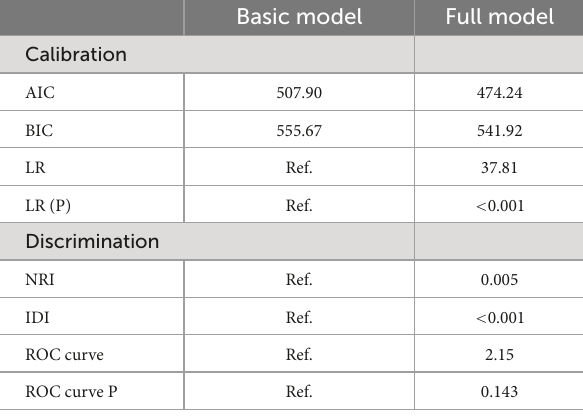
related to have a young age, and in patients with bipolar disorder, the incidence of NSSI was significantly lower in patients between 31 and 60 years old group than 18?–30 years patients. Finally, duration of illness for more than 10 years were more likely to have NSSI than those less than 3 years. (25). Our results also supported that patients with NSSI are younger and had shorter duration of illness, but age and duration of illness did not show statistical significance in the LASSO regression, likely because LASSO regression eliminated the multicollinearity and removed the interaction between age, duration of illness and age of onset. In clinical work, more attention should be given to the patients with an early age of onset for prevention.